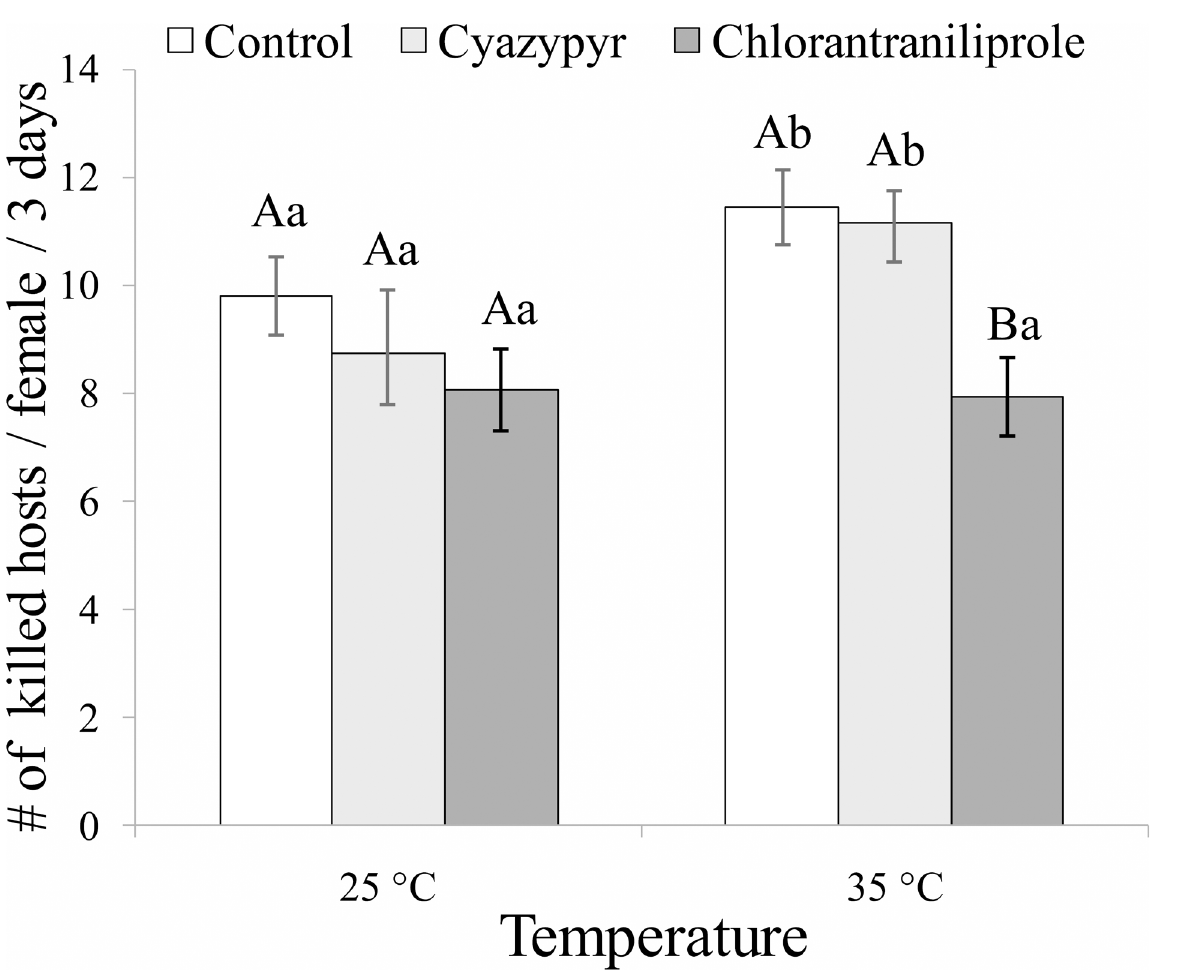
Fig 3. Sublethal effects on biocontrol activity. Means ( ± SEM) of number of host larvae killed in three days by each tested Bracon nigricans female previously exposed for three days to residues at three constant temperatures. Columns bearing the same letter (upper case letters: within the same temperature regime; lower case letters: within the same tested insecticide) are not significantly different ( P > 0.05; ANOVA with LSD post hoc test for multiple comparisons).